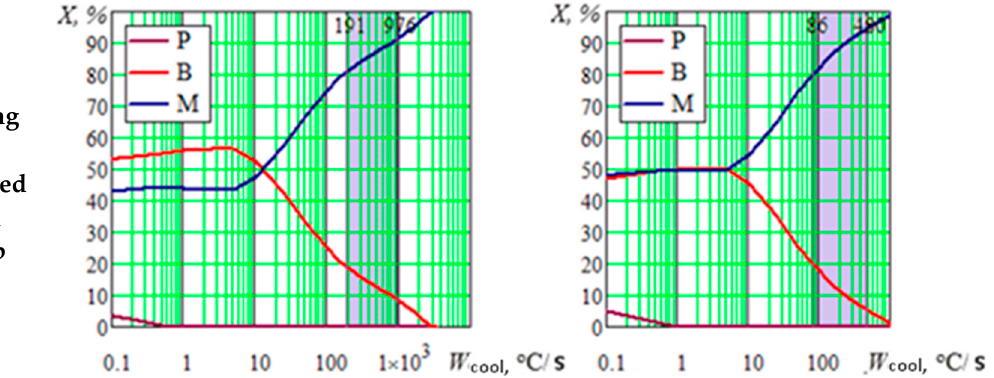
Figure 7. Structural diagrams for the TEZ two parts (a welded joint from the 20H3MVF steel): P—perlite, B—bainite, M—martensite (the diagrams show the range of instantaneous cooling rates in the depth of welded joints).